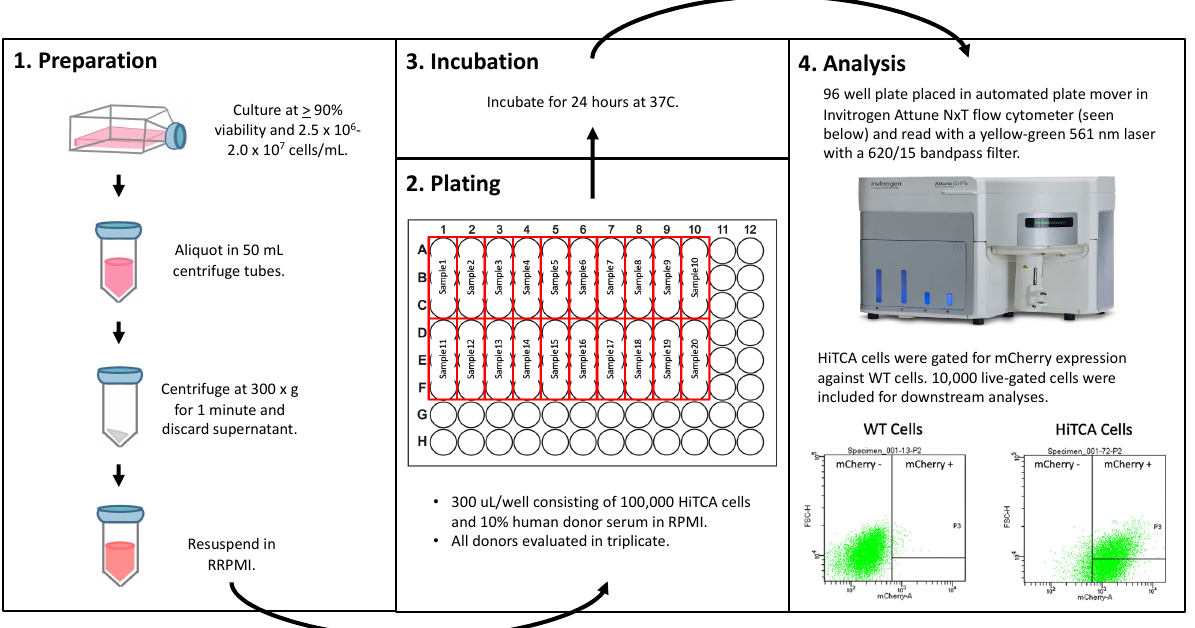
Figure 3. HiTCA Protocol. HiTCA protocol details include (1) preparation, (2) plating, (3) incubation, and (4) analysis.